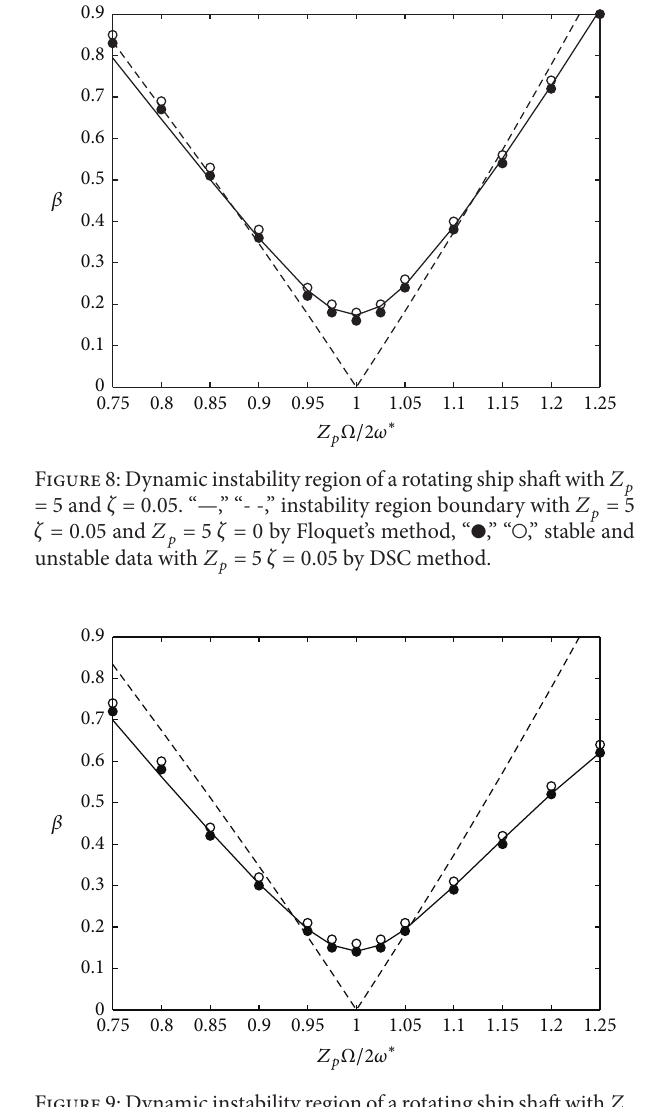
Figure 9: Dynamic instability region of a rotating ship shaft with 𝑍 𝑝 = 3 and 𝜁 = 0.05. “—,” “- -,” instability region boundary with 𝑍 𝑝 = 3, 𝜁 = 0 by Floquet’s method; “ e ,” “ I ,” stable and 𝜁 = 0.05 and 𝑍 𝑝 = 3, unstable data with 𝑍 𝑝 = 3, 𝜁 = 0.05 by DSC